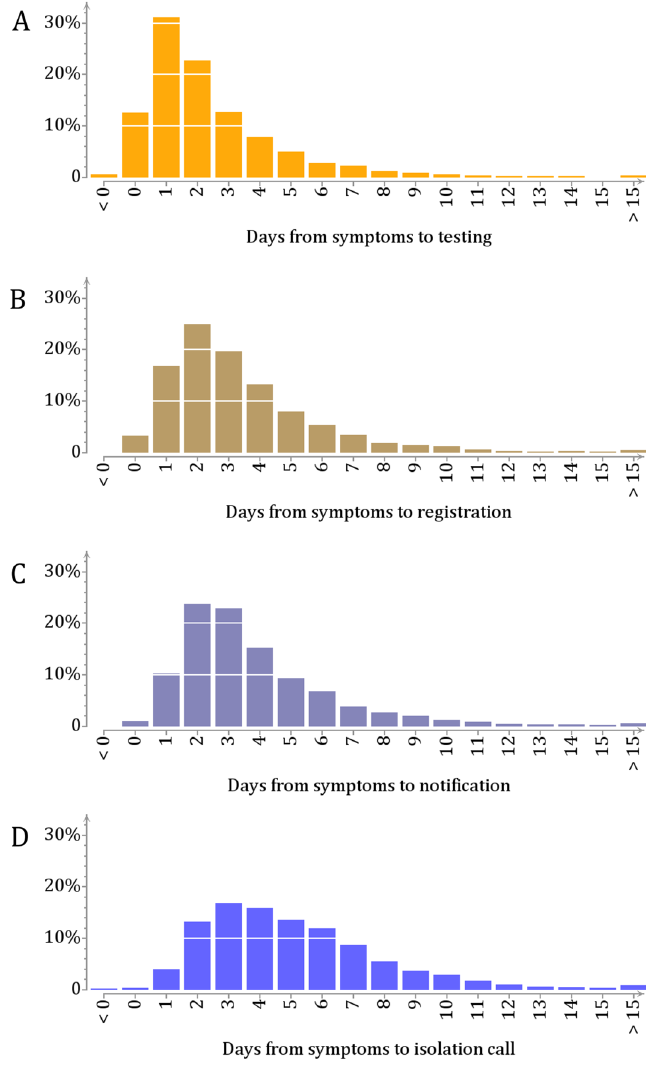
Figure 2. Time lags in case isolation. Based on 4622 SARS-CoV-2 cases, the figure shows the distributions of the time lag in days from symptoms to ( a ) testing (mean 2.4 days; median 2 days; ( b ) registration (mean 3.3 days; median 3 days); ( c ) notification (mean 3.8 days; median 3 days); and ( d ) isolation call (mean 5.0 days; median 5 day). The corresponding cumulative distributions of the time lags are shown in Supplementary Fig.